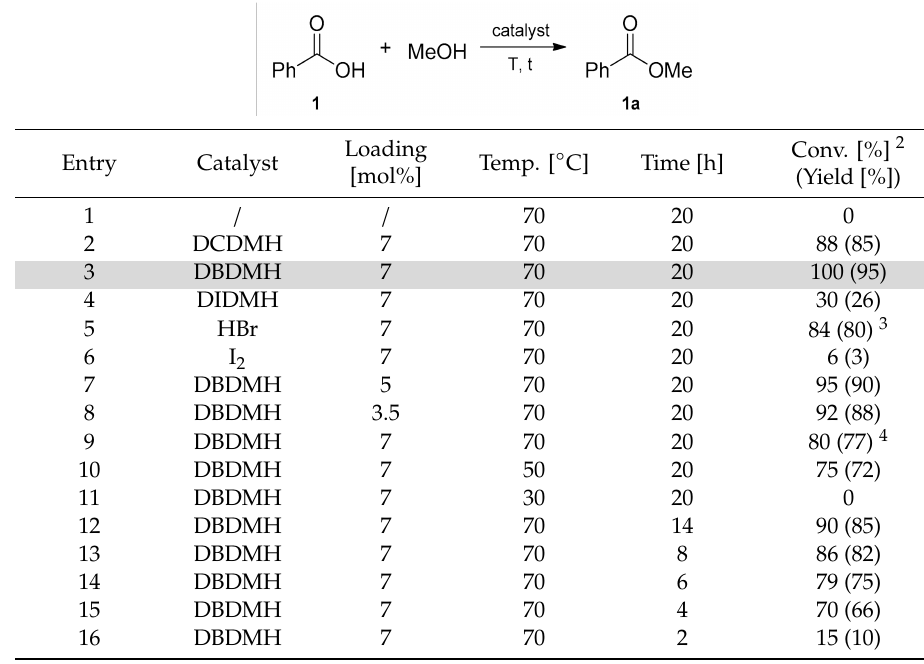
Table 1. Optimization of reaction conditions 1